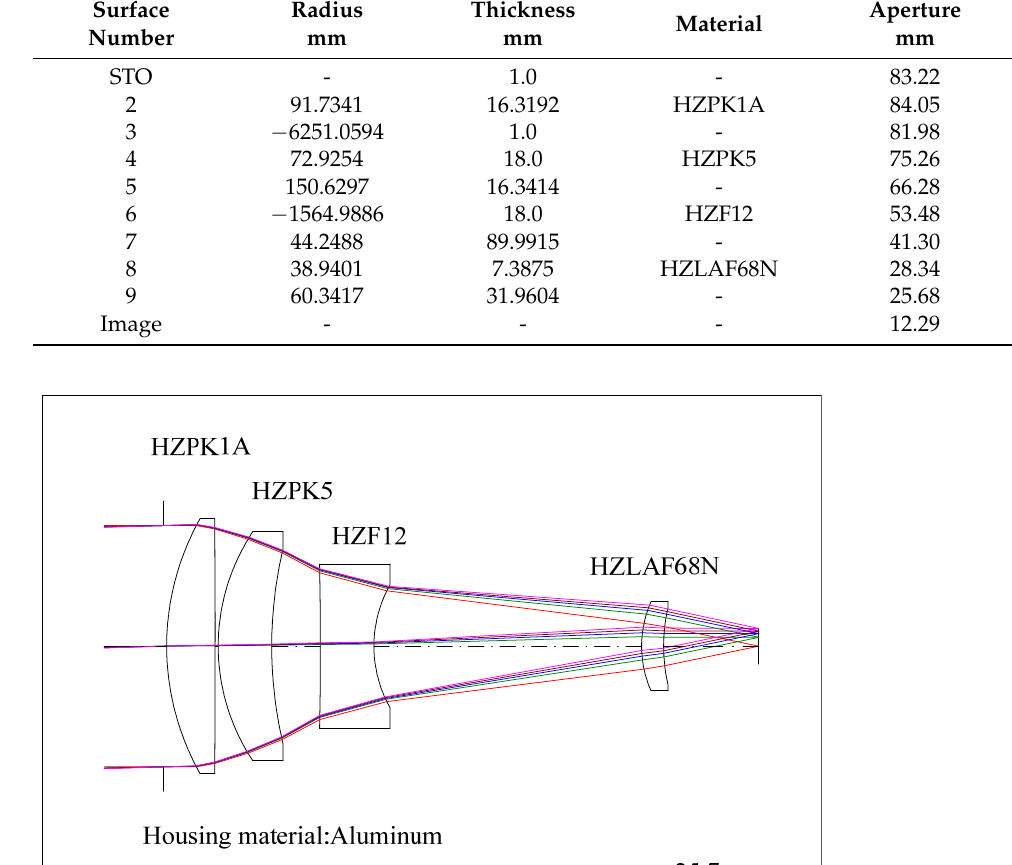
Table 2. Lens data.